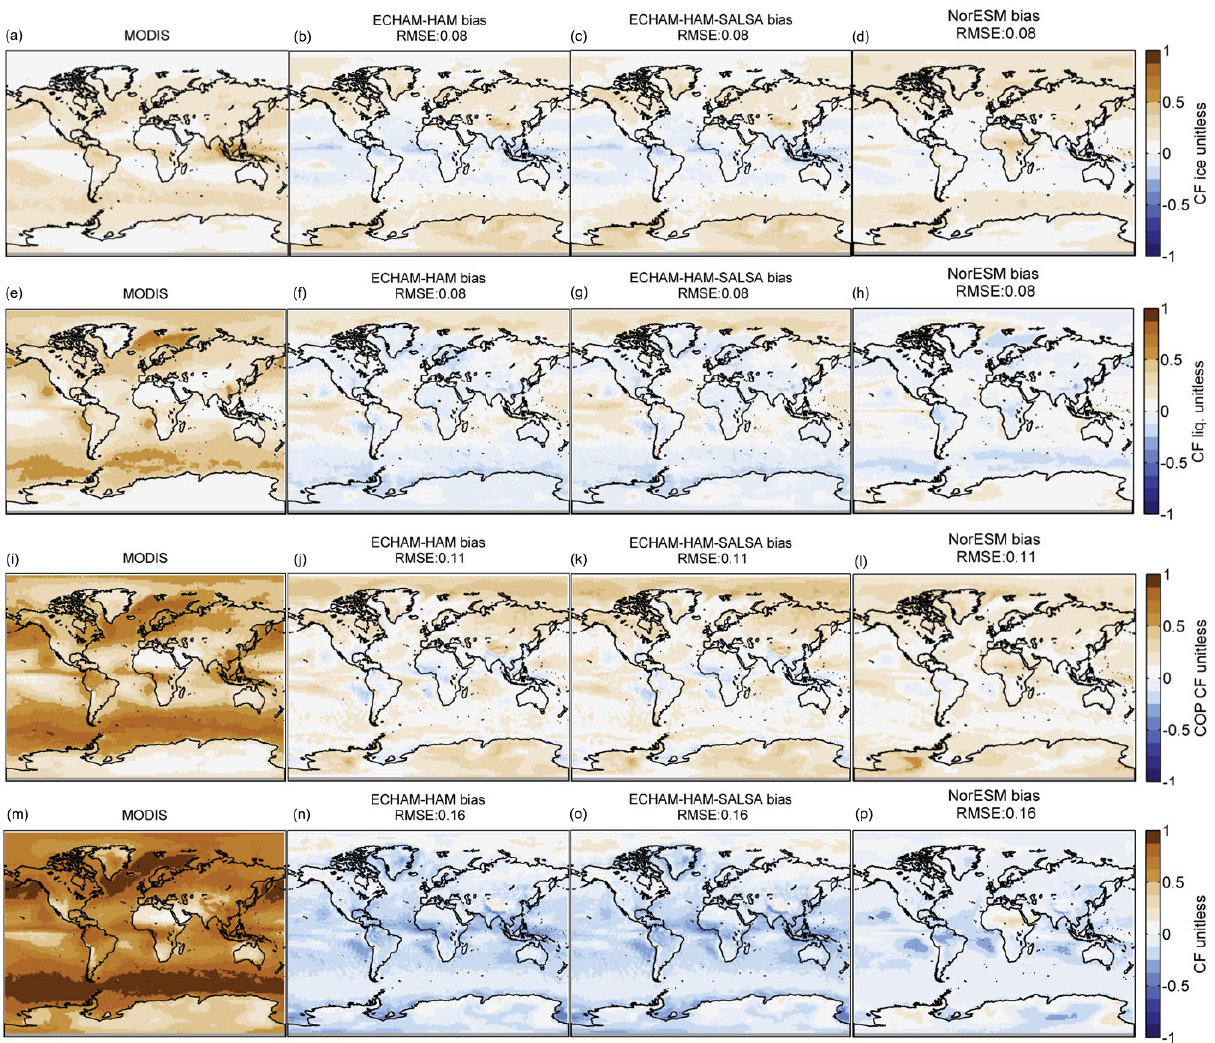
Figure 1. Annual global mean bias in cloud fraction. The bias represents the difference between MODIS-COSP diagnostics from ECHAM- HAM, ECHAM-HAM-SALSA, NorESM, and MODIS observations. COSP-simulated total ice and liquid cloud fractions are compared with MODIS retrieval ice fraction (b–d) and with MODIS retrieval liquid cloud fraction (f–h) , respectively. COSP-simulated total cloud fraction is compared with MODIS retrieval total cloud fraction (COP CF) (j–l) and cloud mask cloud fraction (CF) (n–p) . Pixels with liquid cloud fraction ≤ 30% are screened.The averages represent in-cloud values. High latitudes (lat > 60 ◦ N or lat > 60 ◦ S) are excluded in the computation of the root mean square error (RMSE). MODIS spatial distribution is presented as reference (a, e, i, m)